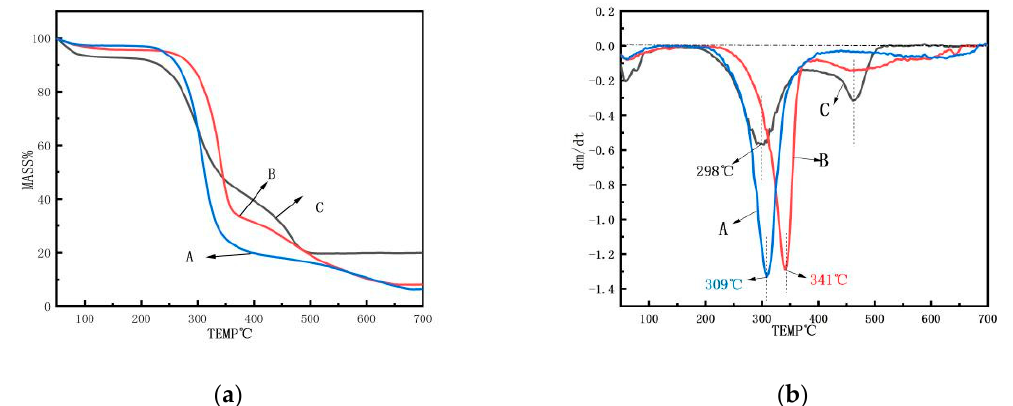
Figure 8. ( a ) TG spectra and ( b ) the first derivative TG thermograms of (A) Artemisia vulgaris bast powder; (B) Artemisia vulgaris bast microcellulose fiber, and (C) Artemisia vulgaris bast nanocellulose